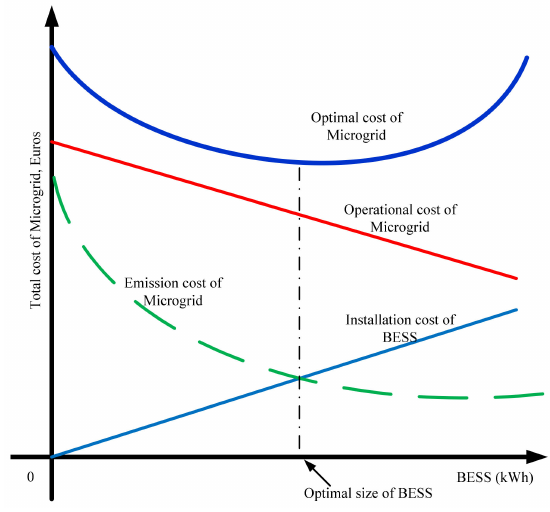
Figure 10. Trade-off points in sizing of BESS.